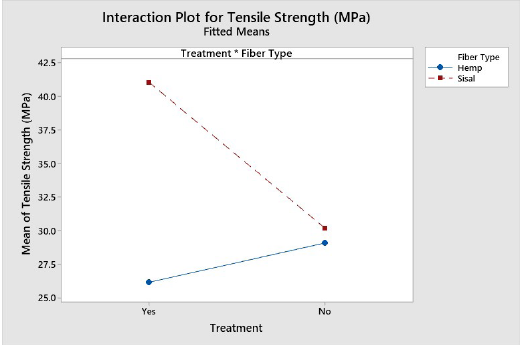
Figure 7. Pareto chart for the tensile strength of the bio-PP composite.